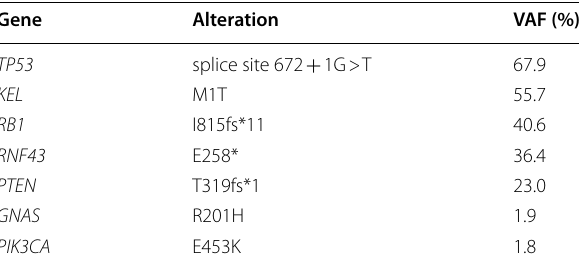
Table 1 Gene mutations in the tumor specimen detected by